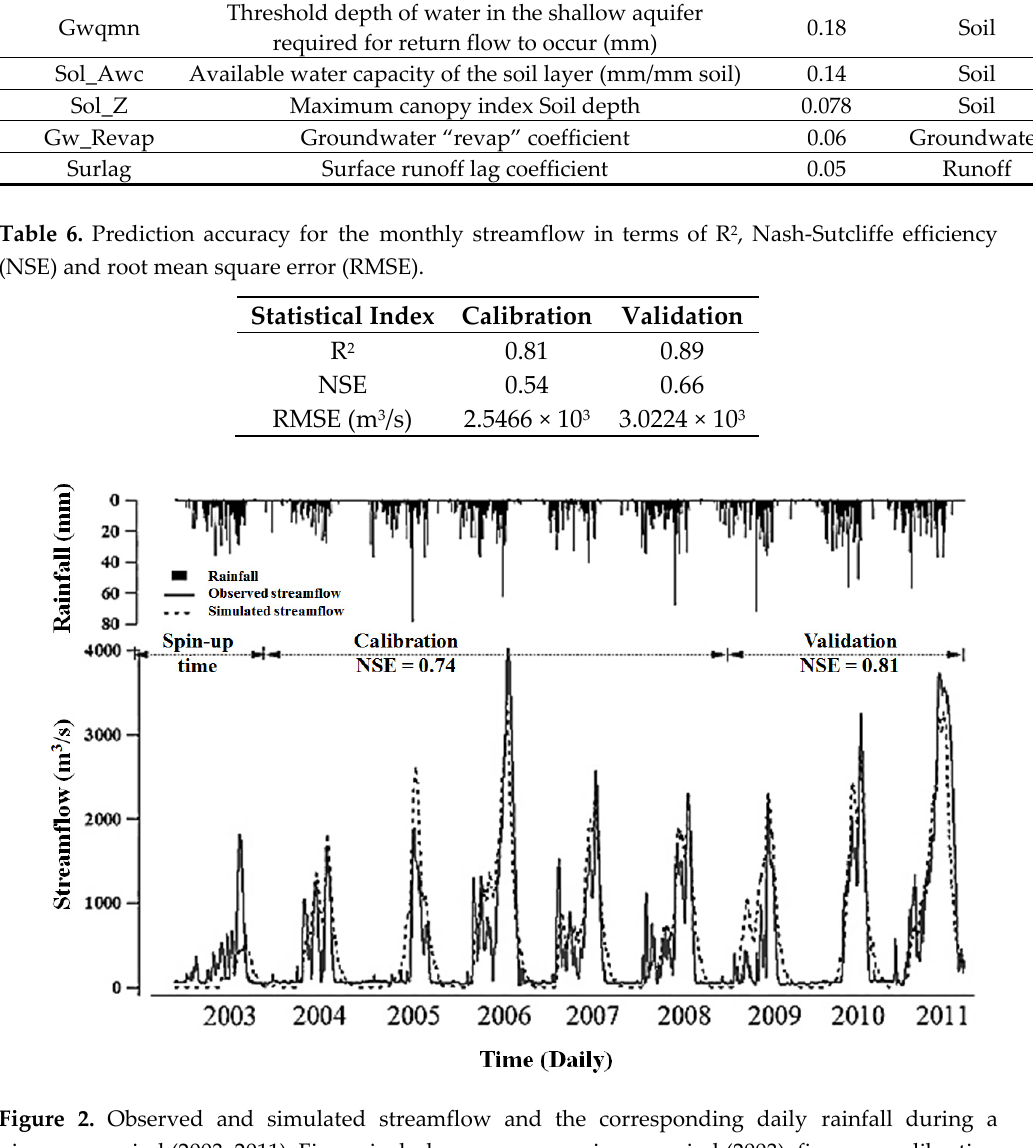
Figure 2. Observed and simulated streamflow and the corresponding daily rainfall during a nine-year period (2003–2011). Figure includes a one-year spin-up period (2003), five-year calibration period (2004–2008), and three-year validation period